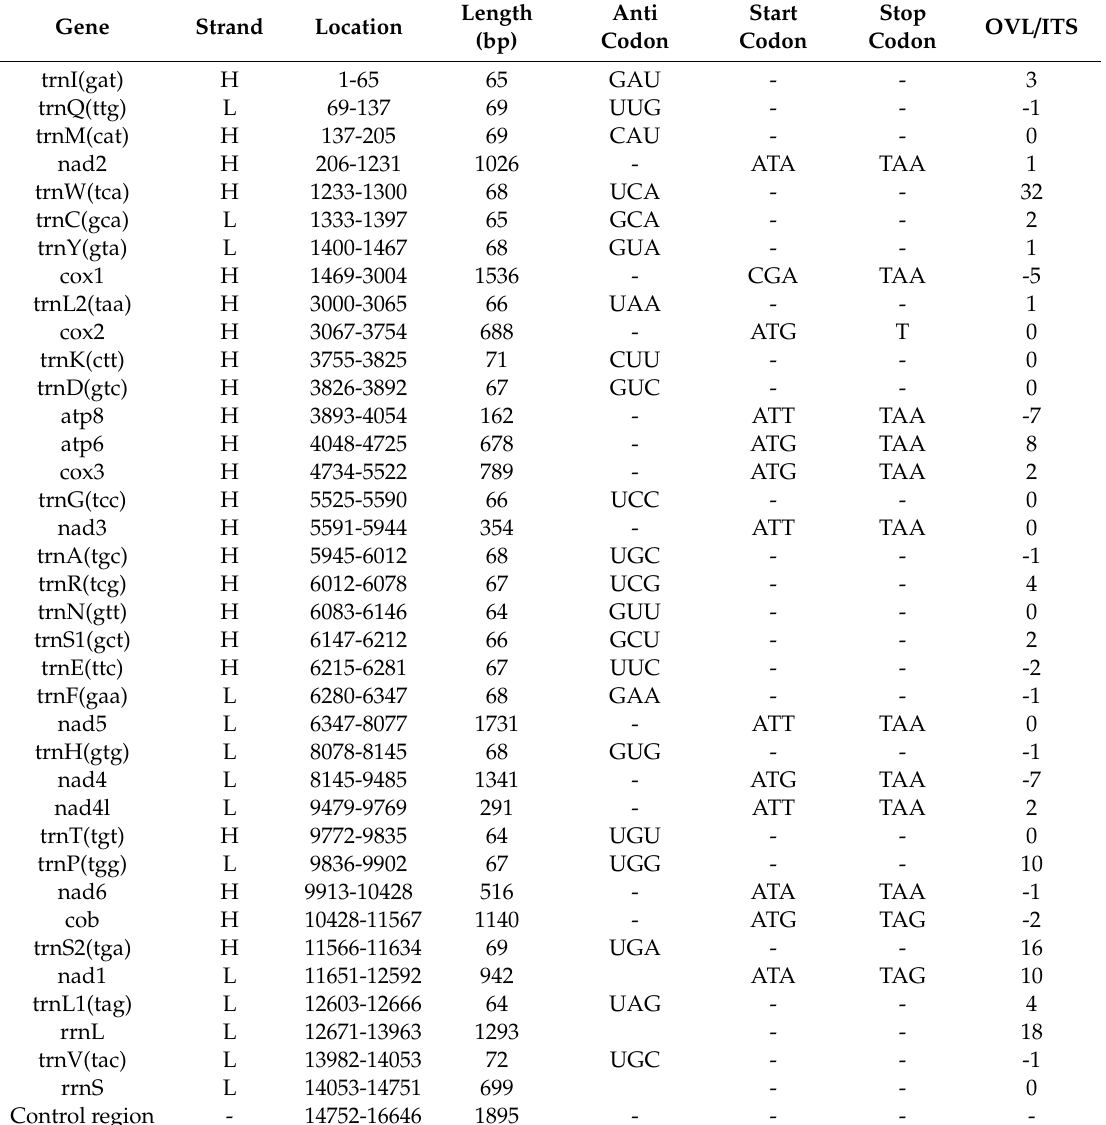
Table 1. Organization of the Amara aulica mitochondrial